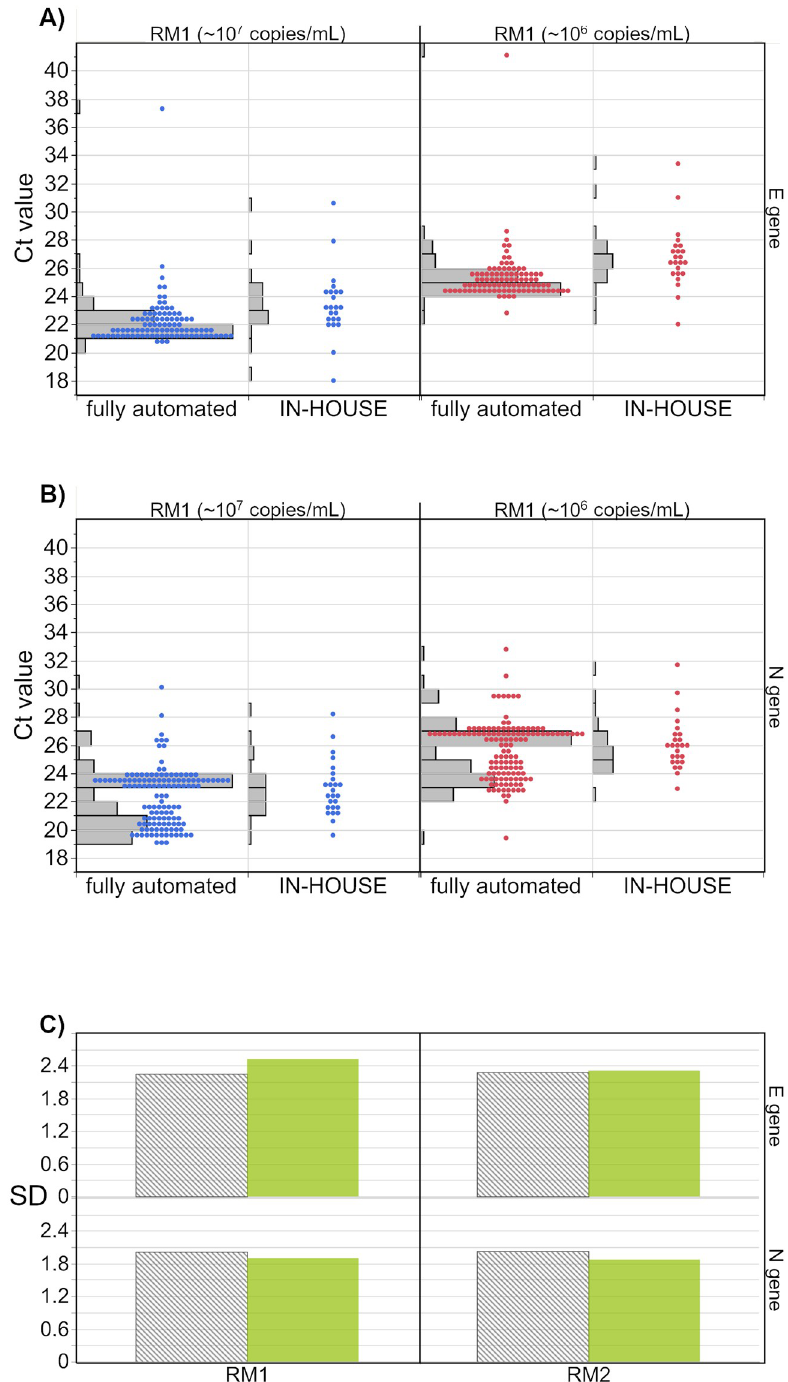
Fig 8. Comparison of Ct values generated by in-house tests with fully automated systems for both samples for the E gene (A), the N gene (B) as well as the corresponding standard deviations (SD). The SD were generated by combining all results obtained by the corresponding test